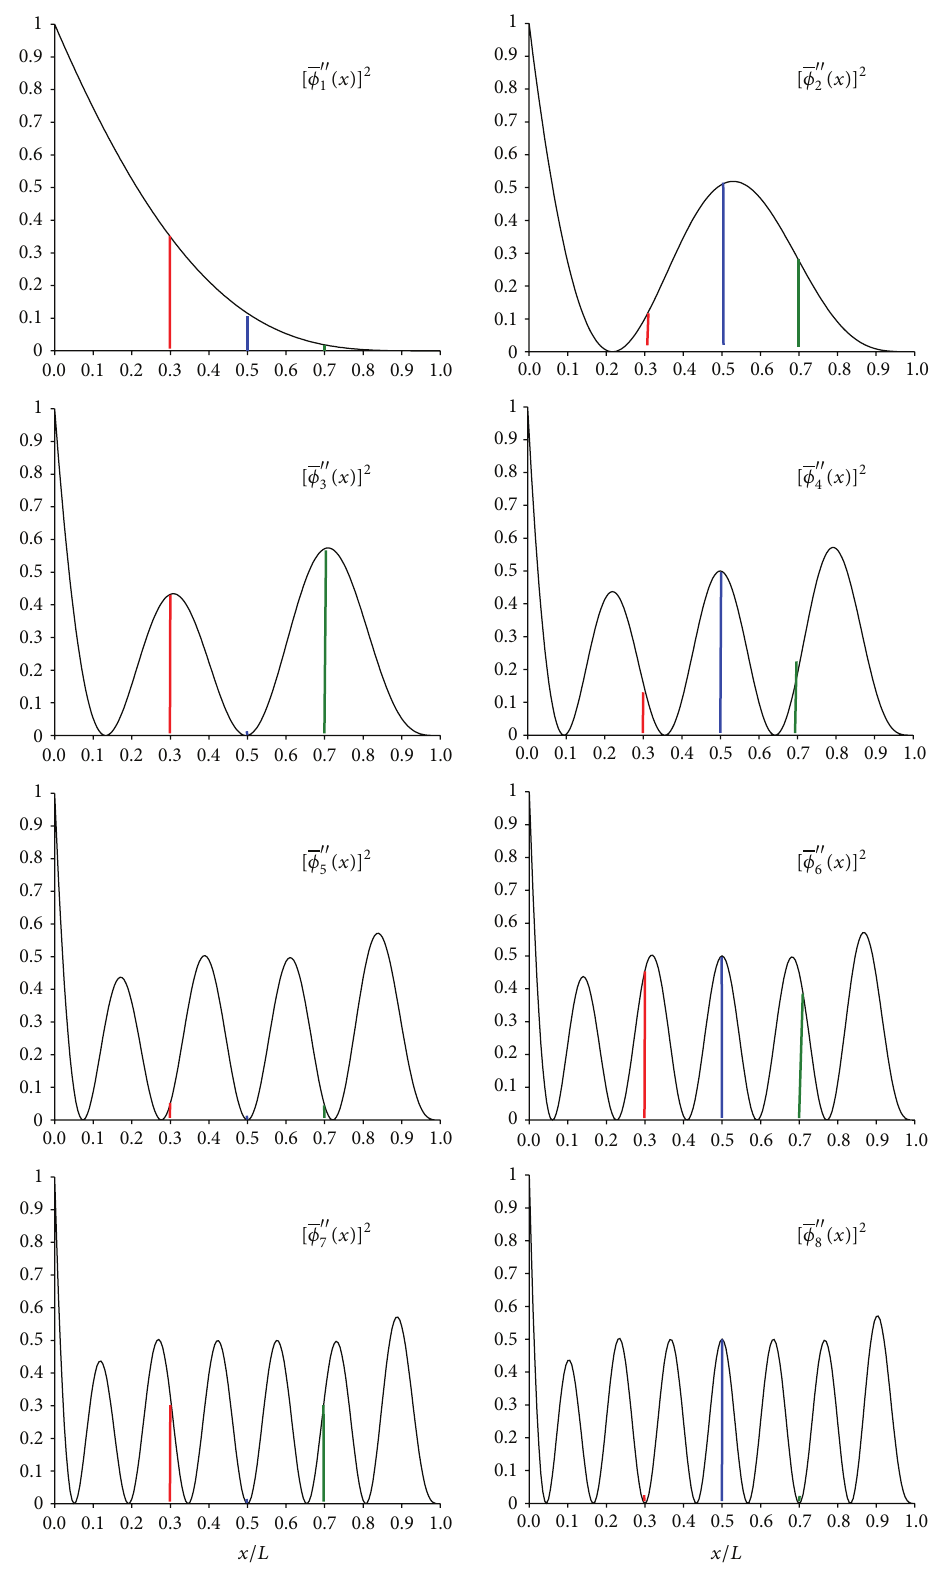
2 for the damage placed at 𝑥/𝐿 = 0.3 (red line), 𝑥/𝐿 = 0.5 (blue